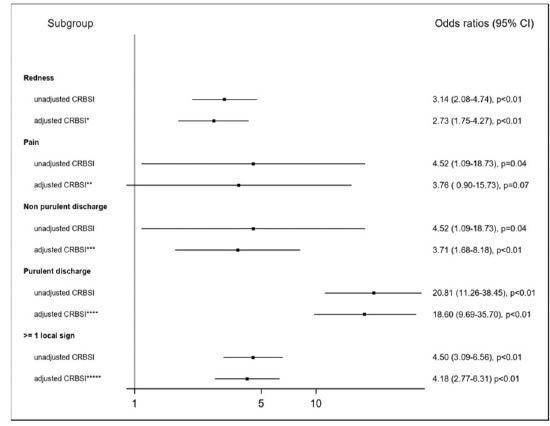
Fig. 1 Unadjusted and adjusted CRBSI‑risk for the different local